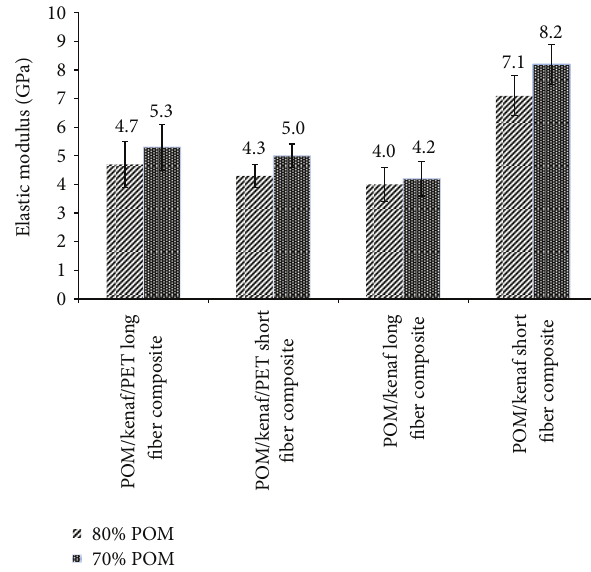
Figure 3: Elastic moduli of the controlled samples.